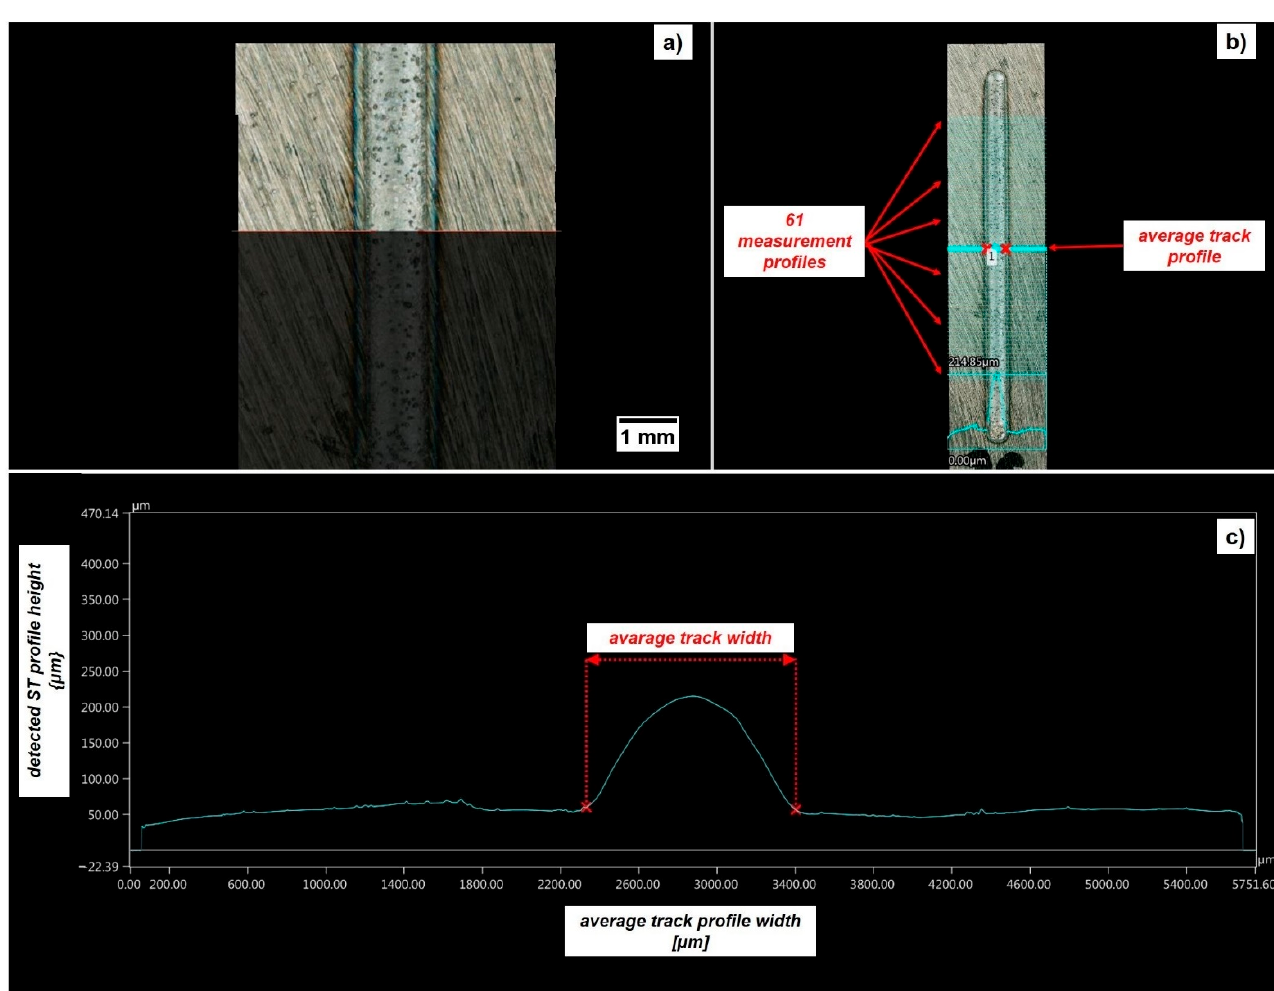
Figure 5. Single Track (ST) acquisition and characterization: ( a ) Inconel 718 ST acquisition; ( b ) tracing of 61 profiles crossing the ST length; ( c ) average ST profile